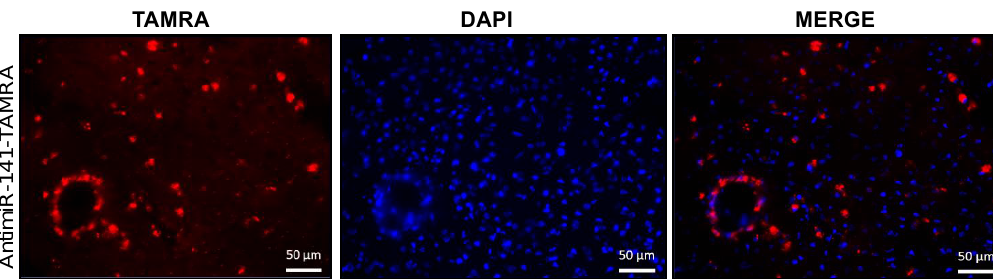
Figure 7. In vivo biodistribution of PS-TAMRA after tail vein injection (48 h after stroke onset) in mice (n = 4) at two days after stroke in the paraformaldehyde fixed tissue of ischemic hemisphere. Blue (nucleus; DAPI), red: antimiR-TAMRA). The scale bar is 50 µM.